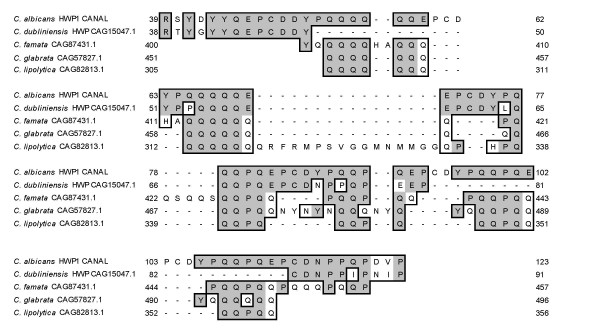
Alignment of sequences of proteins of five species of Candida. Regions of homology with HWP1 of Candida albicans are shown within boxes. Shadowed residues stand for sequence identity. Numbers to the left and right indicate the location within the amino acid sequence.